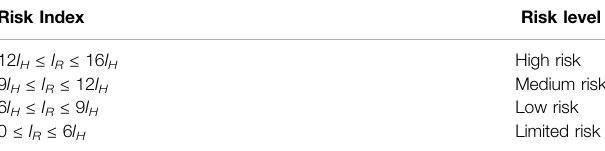
TABLE 2 | Risk Index and risk level for process plant